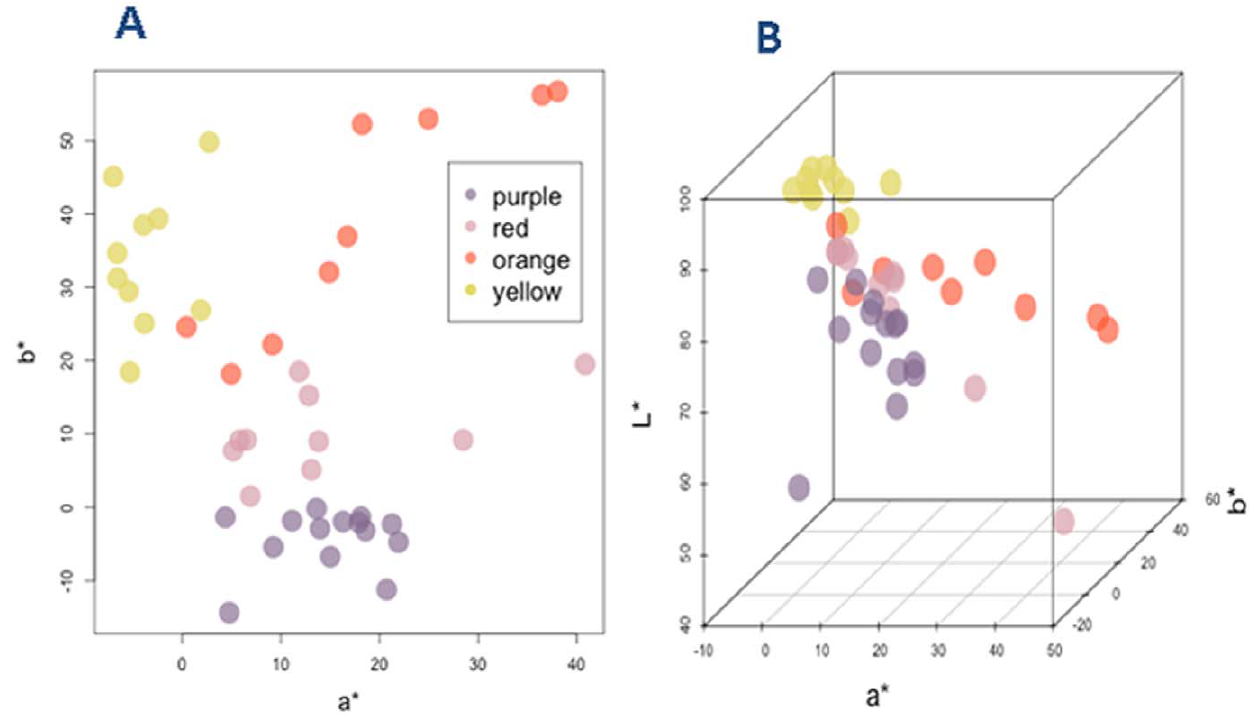
Figure 2. Distribution of Lycorislongituba variants ants by flower colors based on a bivariate ( a* and b* ) (A) and trivariate ( a* , b* , and L* ) CIELAB data (B), respectively. The flower colors were identified by the RHSCC value.